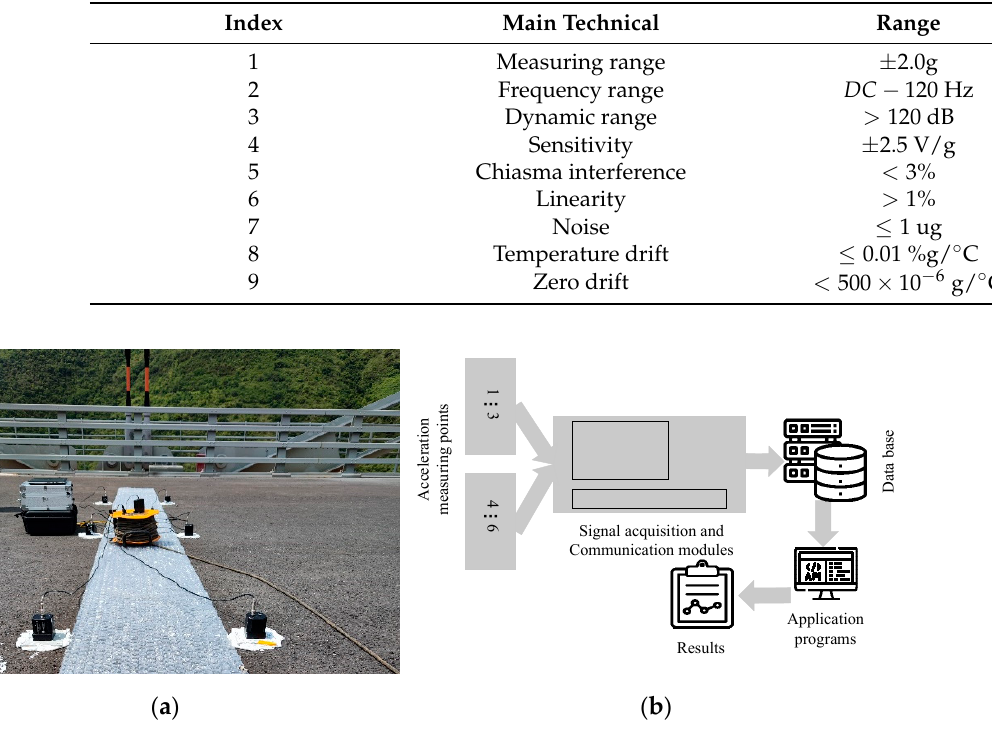
Figure 6. The measurement setup of GT02 force balance accelerometers and diagram of real-time data analysis online. ( a ) The accelerometers in real bridges. ( b ) Diagram of real-time data analysis online. Table 1. Parameters of measurement setup of GT02 force balance accelerometer.